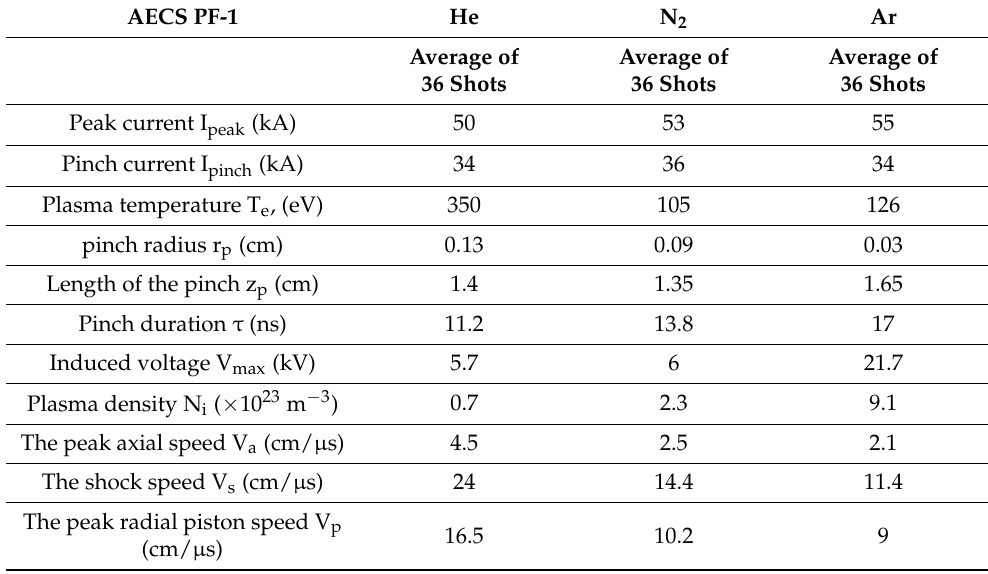
Table 2. Average plasma focus parameters of the AECS PF-1 device at 0.6 Torr during the